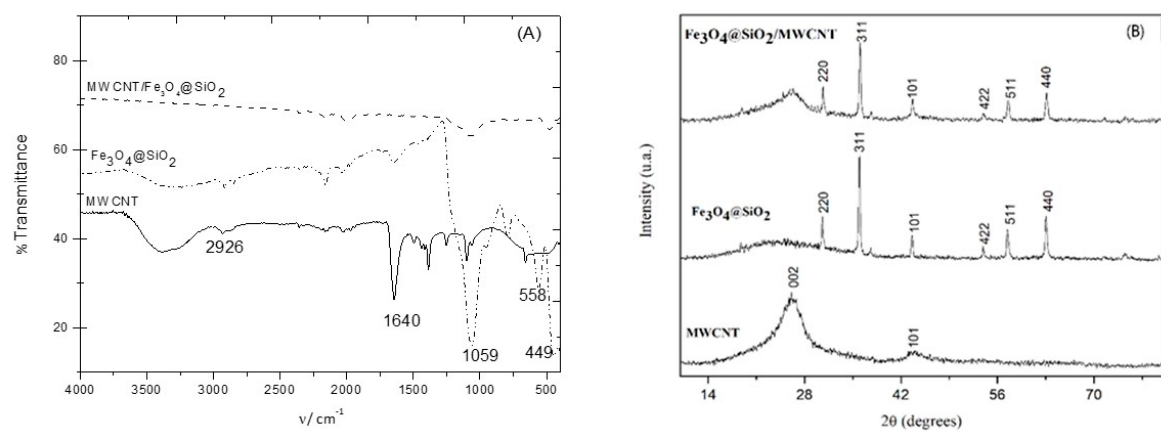
Figure 3. ( A ) FTIR spectra of MWCNT; Fe 3 O 4 @SiO 2 , and MWCNT/Fe 3 O 4 @SiO 2 . ( B ) X-ray diffractograms of MWCNTs; Fe 3 O 4 @SiO 2 and MWCNT/Fe 3 O 4 @SiO 2 .